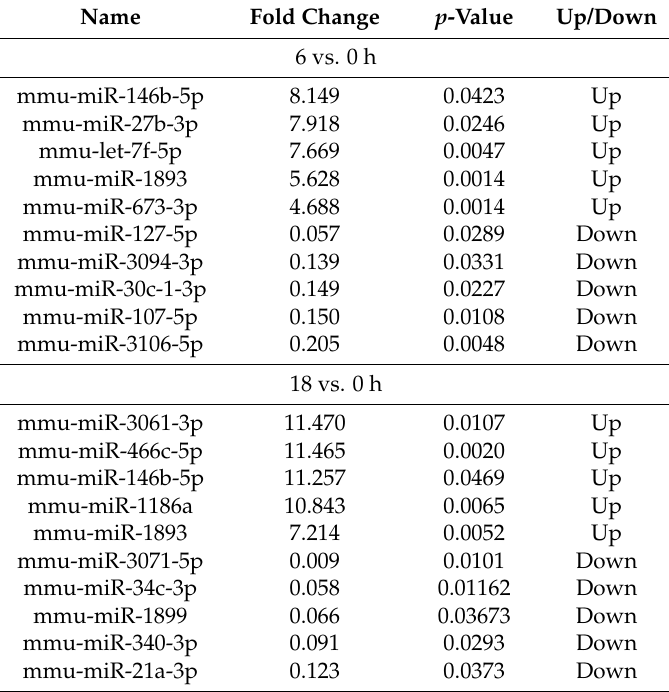
Table 1. The 5 most upregulated and downregulated miRNAs after 6 or 18 h of tensile stress stimulation in comparison with Time 0.